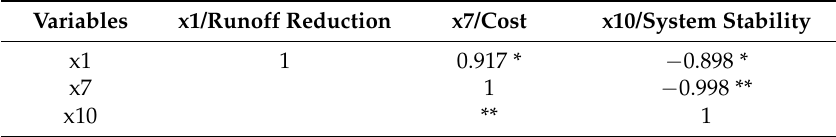
Table 14. CA about the 2nd component of Scenario 02 by SPSS 22.0.